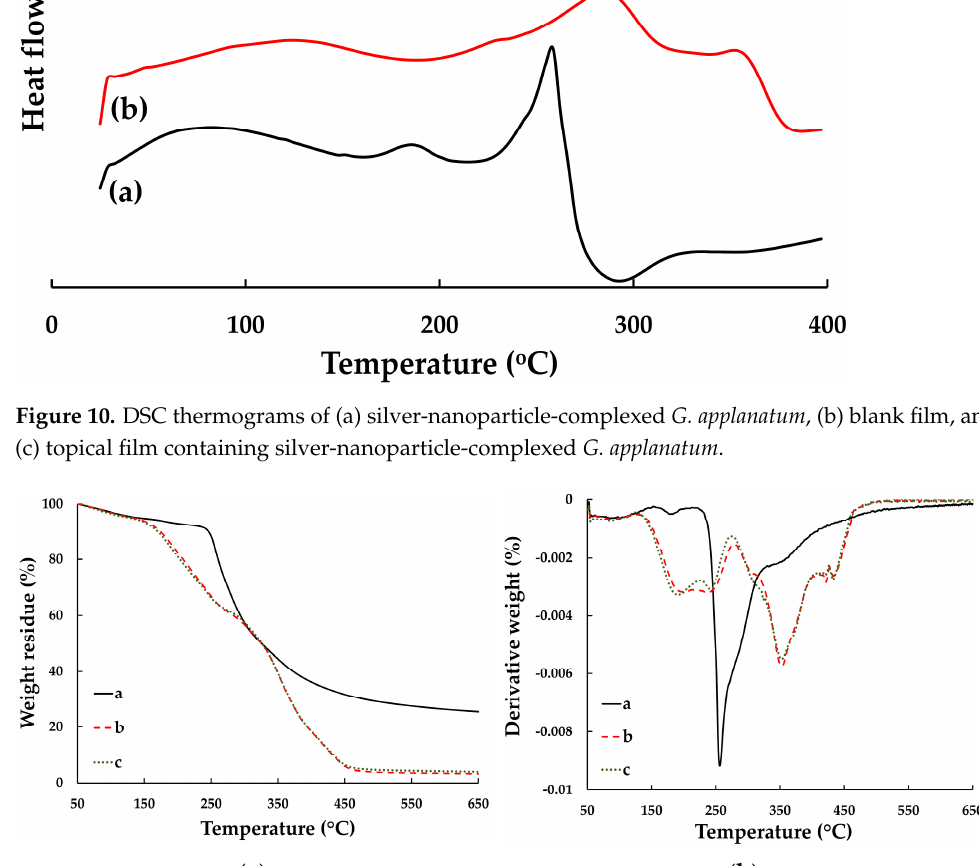
Figure 10. DSC thermograms of ( a ) silver-nanoparticle-complexed G. applanatum , ( b ) blank film, and ( c ) topical film containing silver-nanoparticle-complexed G. applanatum . TGA